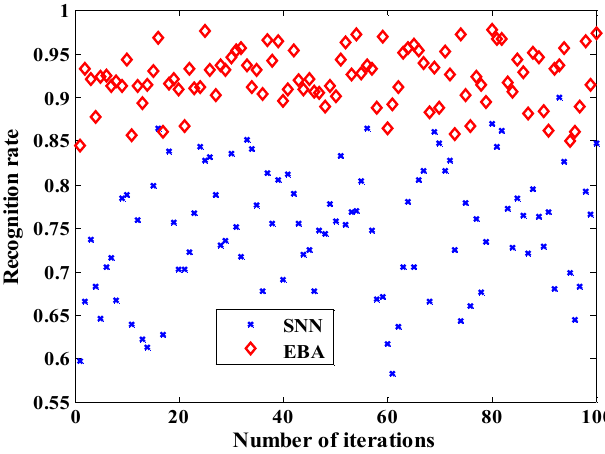
Figure 8. Training and testing both the SNN and EBA with defect on bushing surface.